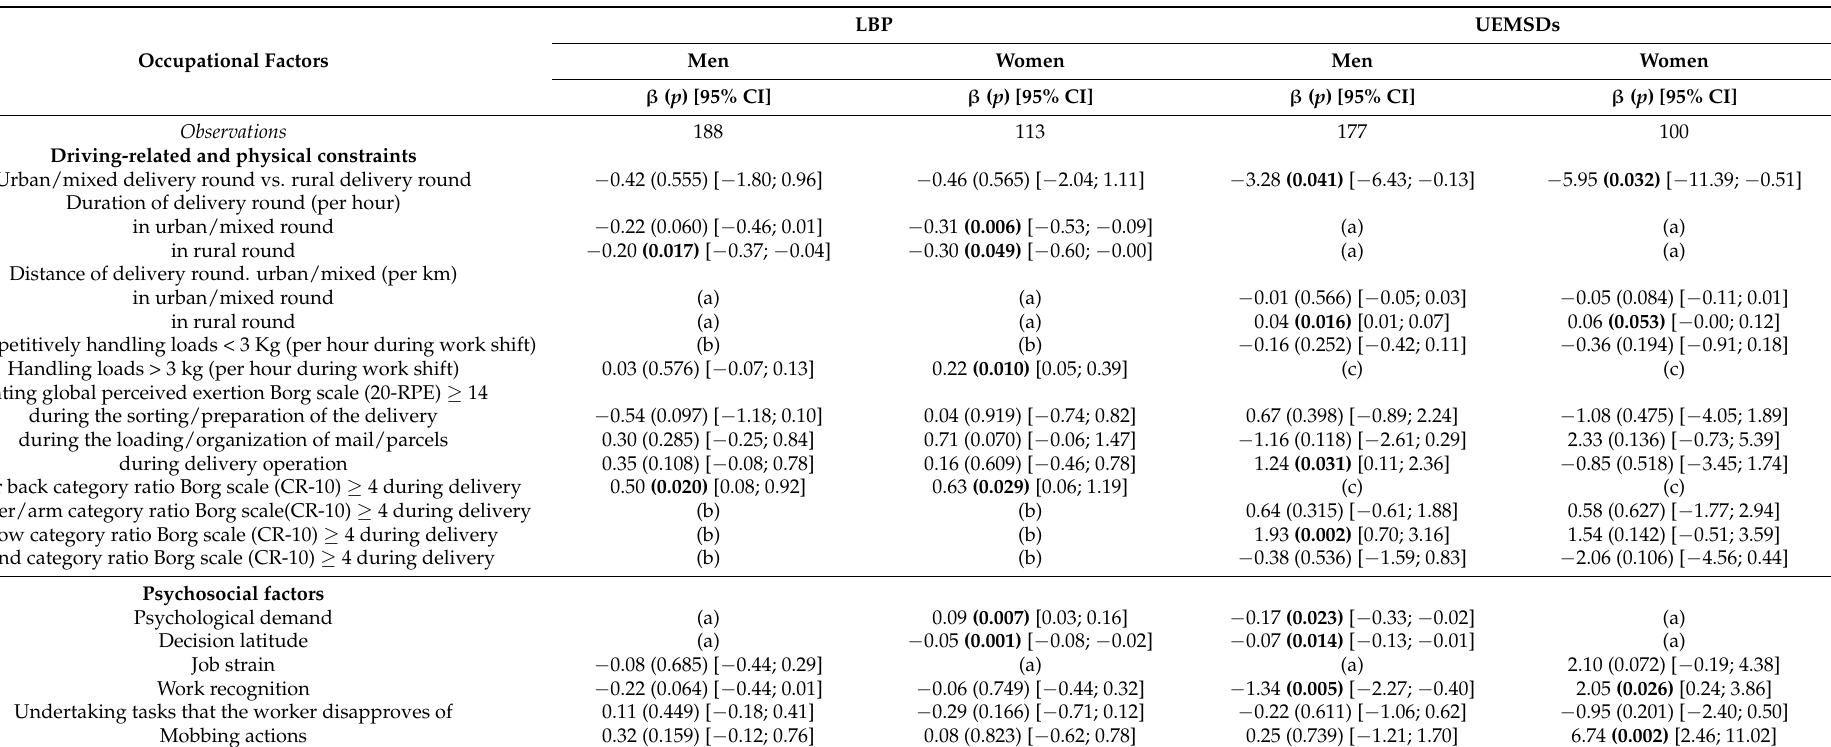
Table 5. Occupational factors associated with low back pain (LBP) and clinically diagnosed upper-extremity musculoskeletal disorders (UEMSDs) in workers driving a light-duty vehicle (LDV), expressed by a regression coefficient β ( p -value) [95% confidence interval] in models adjusted for personal factors. A positive coefficient indicates a risk factor and a negative one indicates a potentially protective factor. Bold figures indicate statistically significant p < 0.05. (a) factor is not in the model selected; (b) factor excluded from models of LBP; (c) factor excluded from models of